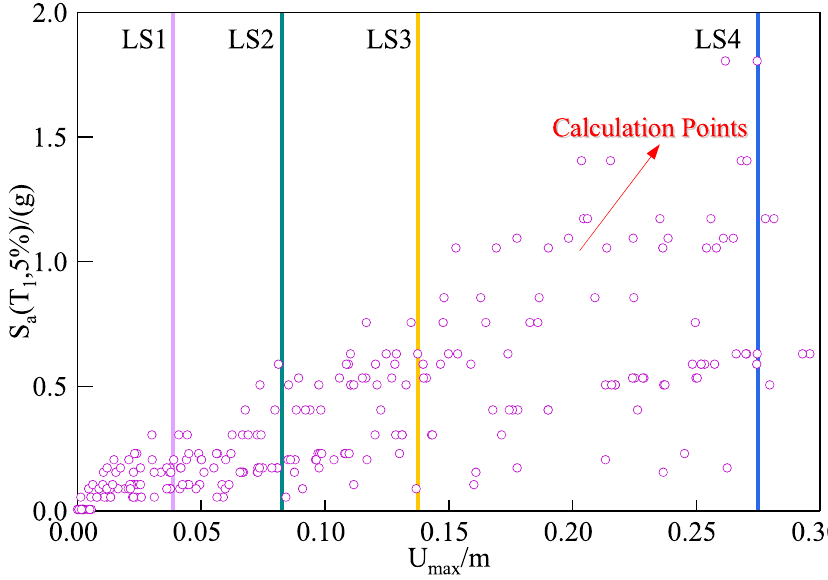
Figure 8. Non-linear time history calculation points of 17 seismic waves.